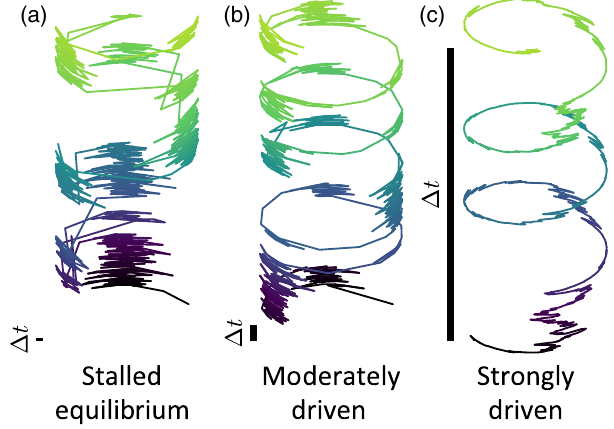
FIG. 20. Effect of nonequilibrium driving on single trajectories. Realization of a stochastic trajectory of the ATPase toy model as function of time (running from dark to bright) at (a) equilibrium M ¼ 0 , (b) at moderate nonequilibrium driving M × 120 ° ¼ B ¼ 5 k T , and (c) at strong driving M × 120 ° ¼ 20 k B of each trajectory is chosen to have the same average number of transitions. To compare the different time units, we add the bars Δ t , which all span the same period of time.